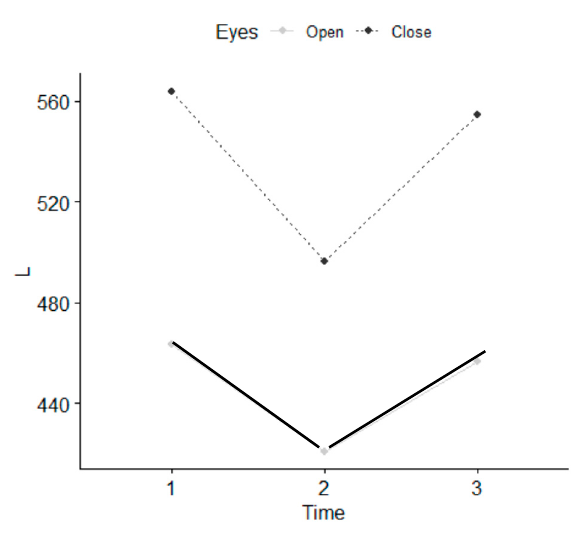
Figure 5. Length (L) parameter, 1 (T0 before), 2 (T1 immediately), 3 (T2 7–10 days).